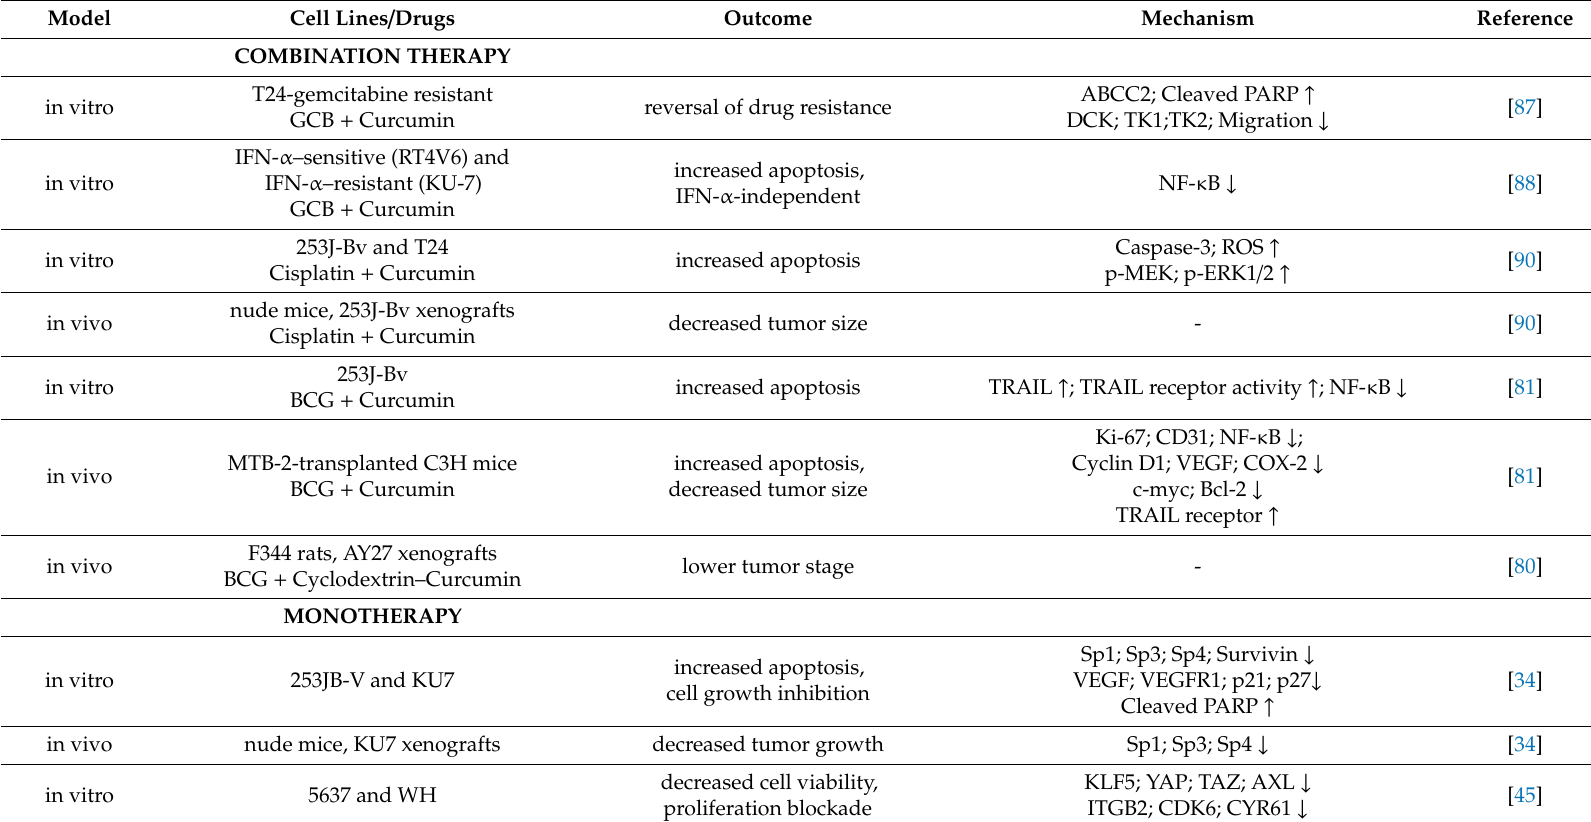
Table 1. E ff ects of curcumin in vitro and in